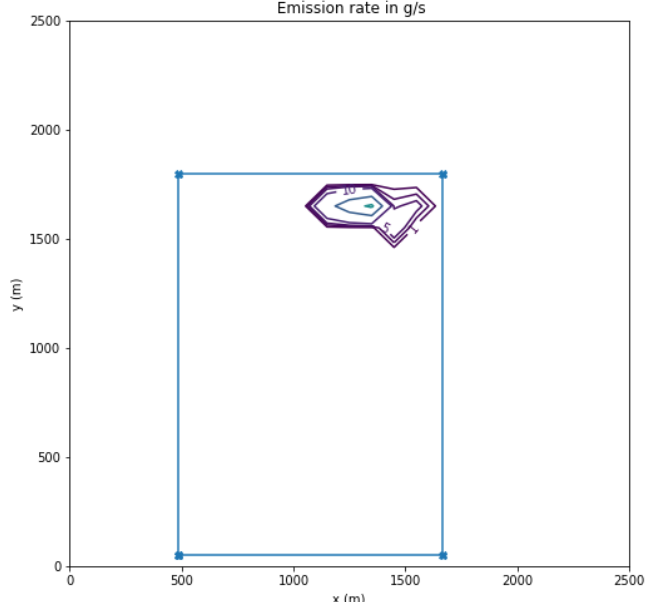
Figure 8. Inferred distribution of landfill emissions of methane for 5 June 2021, 10:24 a.m. to 10:39 a.m., based on MPAL measurements. Contours are drawn for 1, 3, 5, 10, 30, and 50 g/s. Blue line is approximate border of the landfill.